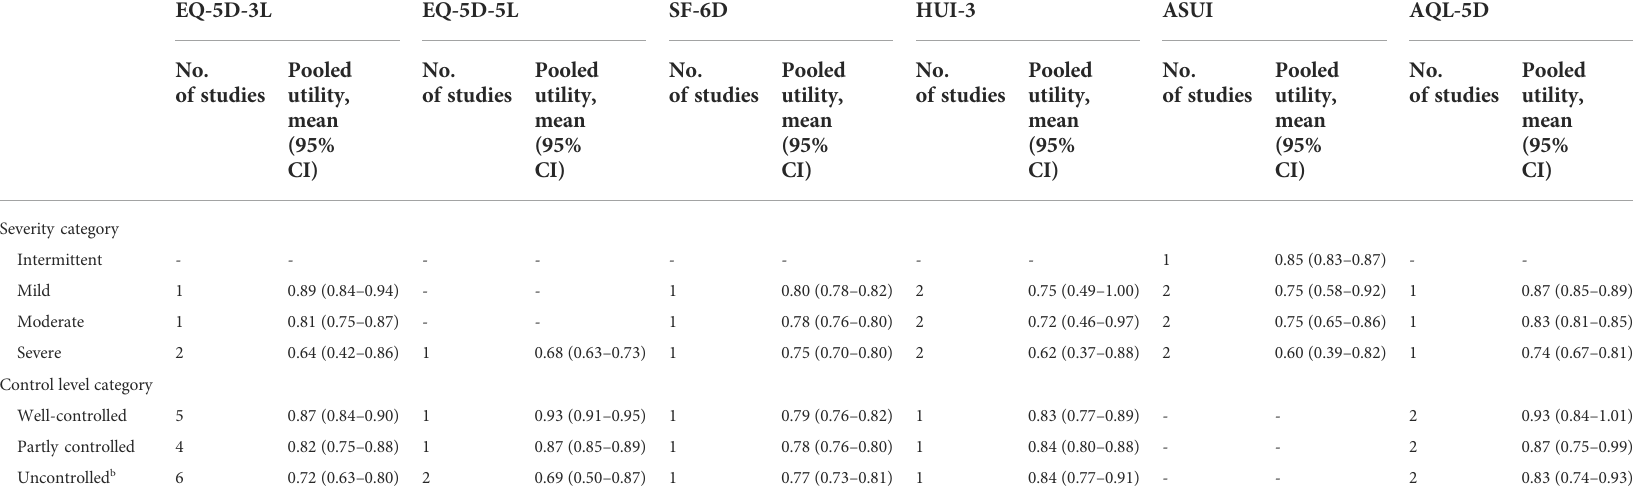
TABLE 3 Results of random effects meta-analyses strati fi ed by asthma severity and control level a